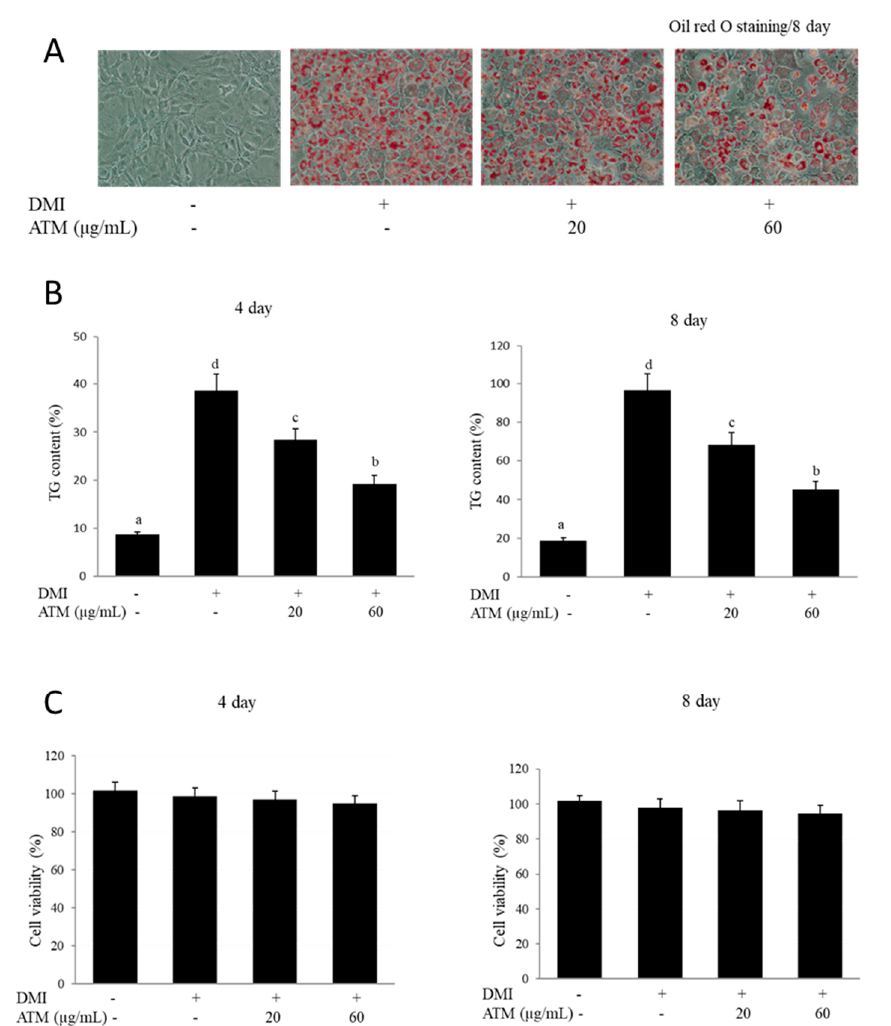
Figure 1. Effects of Acer tegmentosum Maxim (ATM) on lipid accumulation and adipocyte differentiation in 3T3-L1 cells. ( A ) 3T3-L1 preadipocytes were induced to differentiate in the presence or absence of ATM using MDI (0.5 mM 3–isobutyl–1–methylxanthine, 1 μ M dexamethasone, and 0.5 μ g/mL insulin). After 8 days of differentiation, cellular lipid content was assessed by Oil Red O staining. 3T3-L1 cells were induced to differentiate with desipramine (DMI) and ATM in increasing concentrations (0, 20, and 60 μ g/mL) and lipid droplets on day 8 after differentiation were measured by Oil Red O staining. ( B ) Triglyceride (TG) content assay of 3T3-L1 cells on days 4 or 8 after the differentiation process. Intracellular TG contents were normalized by total protein. Three independent experiments were used to represent the error bars. The data shown are representative of at least three independent experiments. The values are presented as the means ± standard deviations (SD). Bars with different letters are significantly different ( p < 0.05) as determined by Duncan’s multiple range test. ( C ) Effect of ATM on viability of 3T3-L1 cells was assessed by the MTT assay. The values are presented as the means ± SD. The data shown are representative of at least three independent experiments.